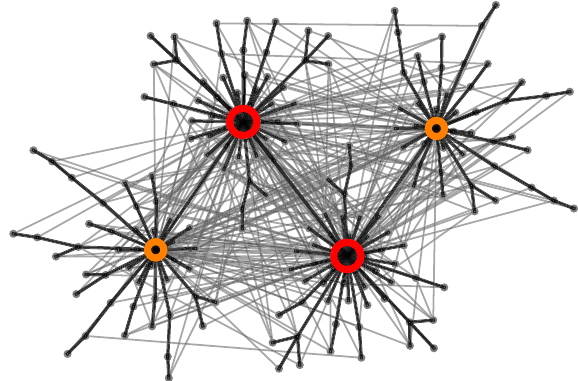
FIG. 3. Undirected kinetic network of the energy landscape of the weakly disordered, triangular NP ensemble illustrated in Fig. 1(b). The two degenerate ground states are indicated by the red circles. Additional hubs ( ρ c ¼ 0 . 3 ) are indicated by orange circles. The thick black segments highlight the transitions that, starting from a given minimum, lead to a lower or equal energy involving the smallest energy barrier [95].